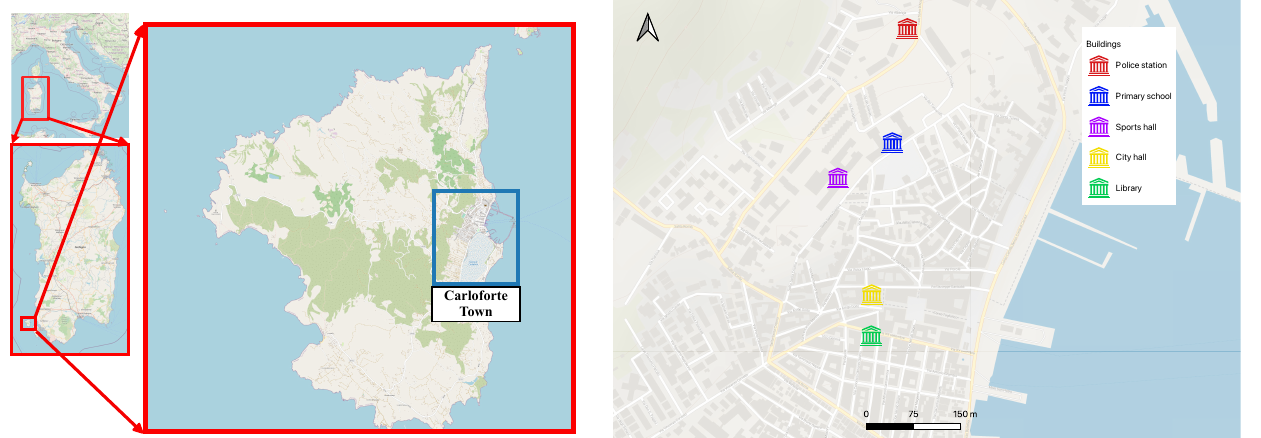
Figure 4. ( Left ): Geographical location of the test site. ( Right ): The position of the test buildings.